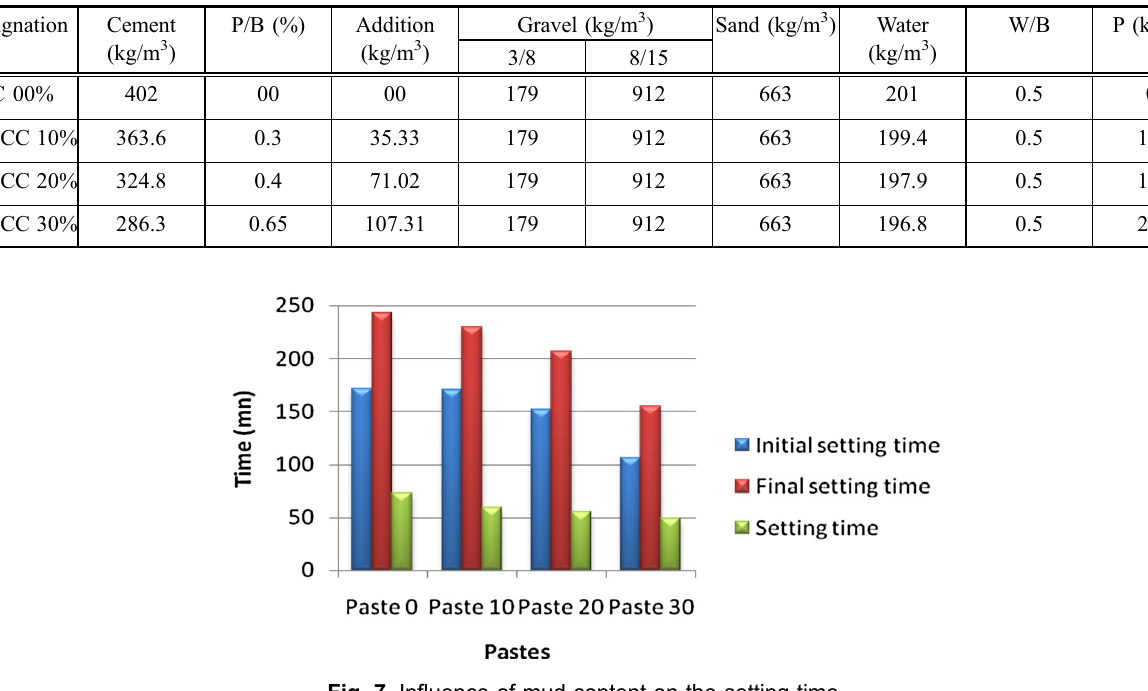
Fig. 7 Influence of mud content on the setting time.